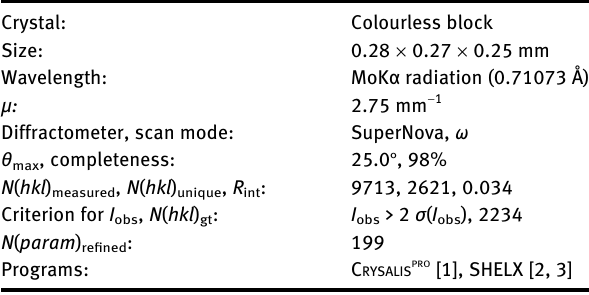
Table  : Data collection and